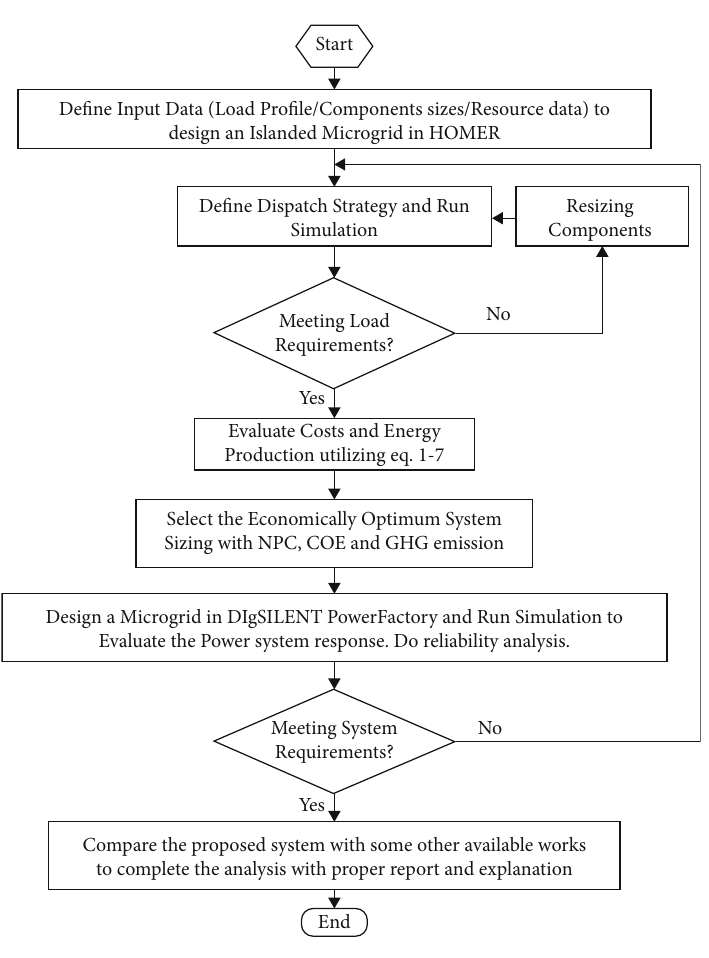
Figure 3: Flow chart for the complete work fl ow of the proposed